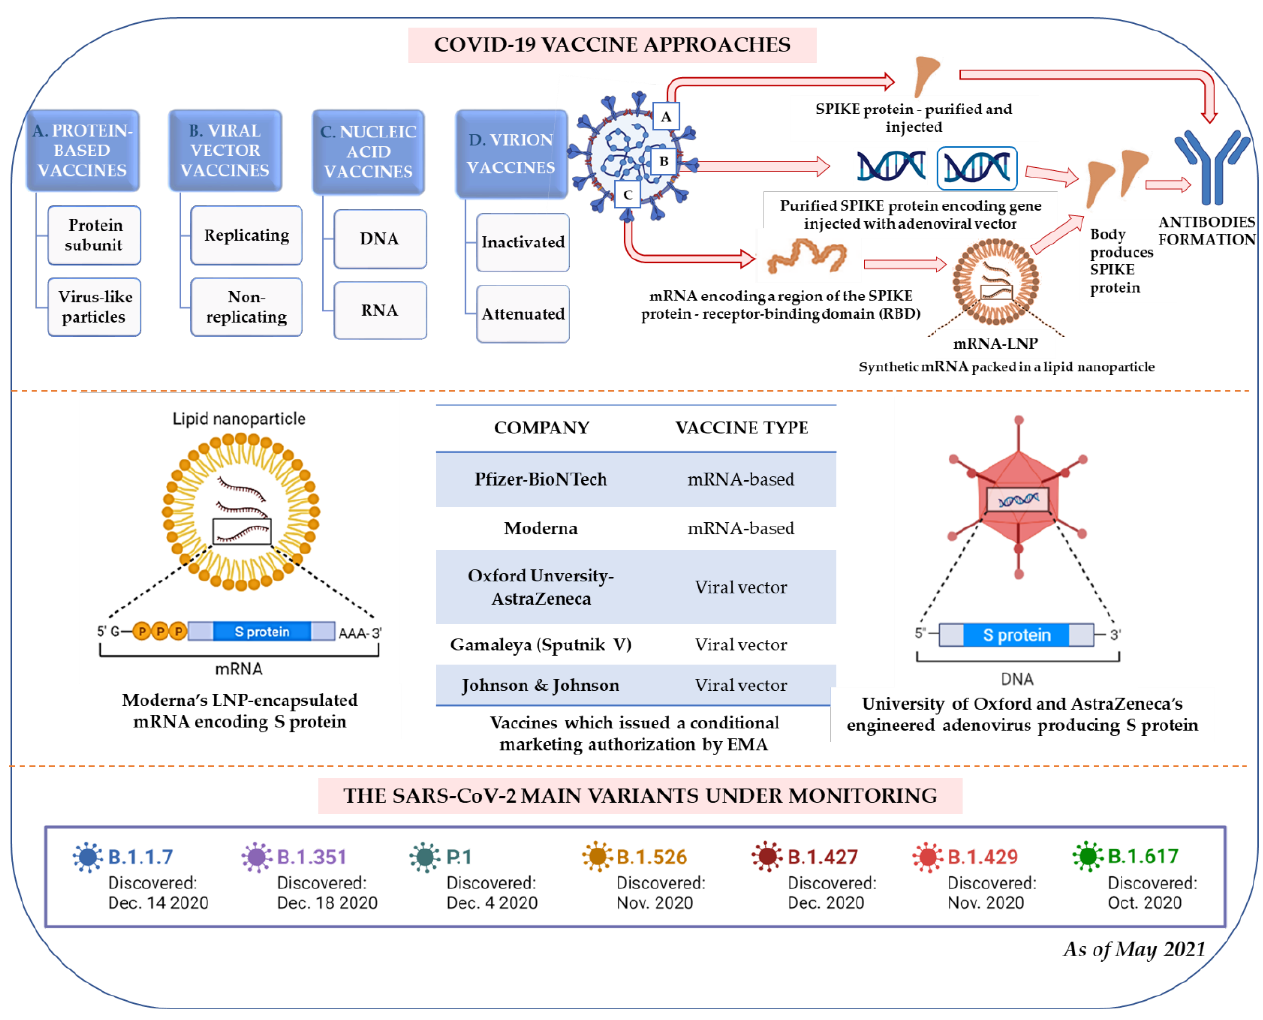
Figure 1. SARS-CoV-2 vaccine approaches and main SARS-CoV-2 variants currently under monitoring.